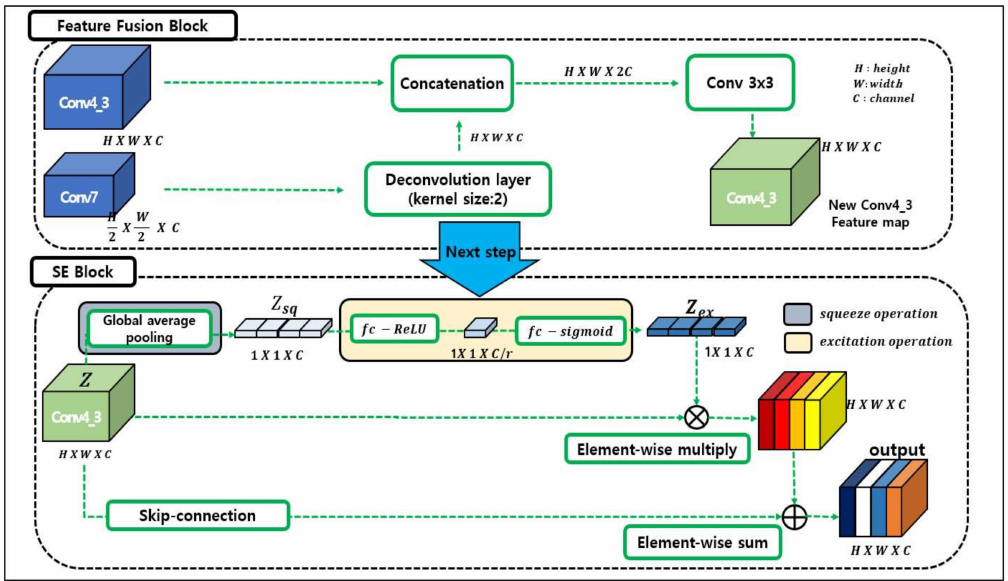
Figure 4. Feature fusion block and squeeze and excitation (SE) block. SE-feature fusion module consists of the SE-block and feature fusion block. The feature fusion block adds a feature map through the deconvolution layer ( upper panel). The SE block compresses the channel and performs the operation to obtain weights of scale-related channels ( lower